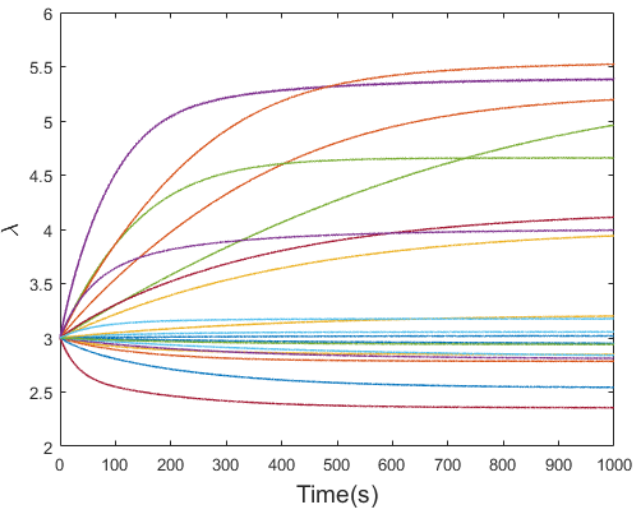
Figure 7. First-order KV-GM rheological model system responses for 20 random Monte-Carlo sam- ples.